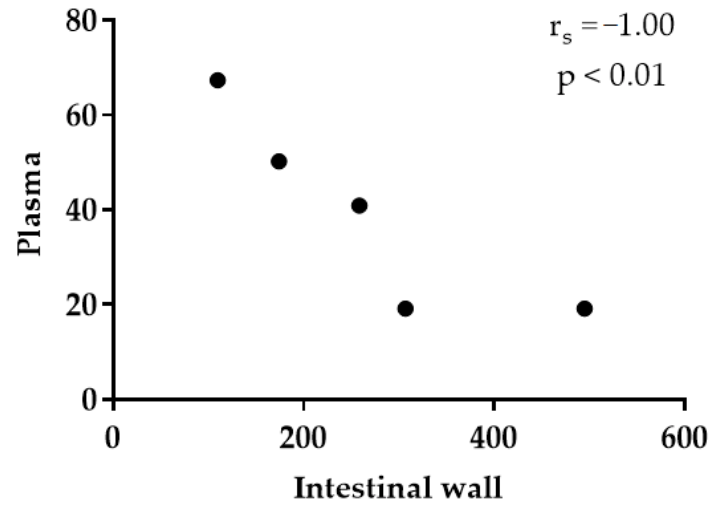
Figure 1. Correlation between plasma (ng/mL) and intestinal wall (ng/g DM).